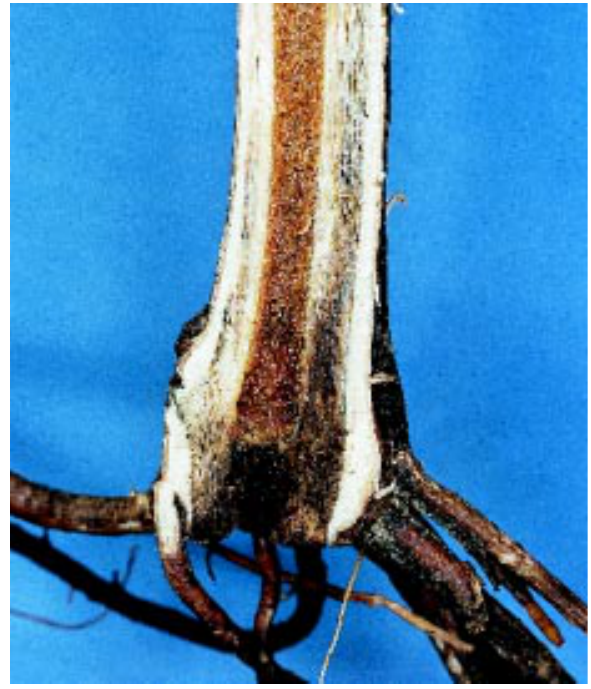
Fig. 2. Discoloured xylem in the wood at the base of a 2-year-old grapevine of the cultivar Victoria/775 Paulsen. From the darken tissue P. chlamydosporum was frequently isolated.